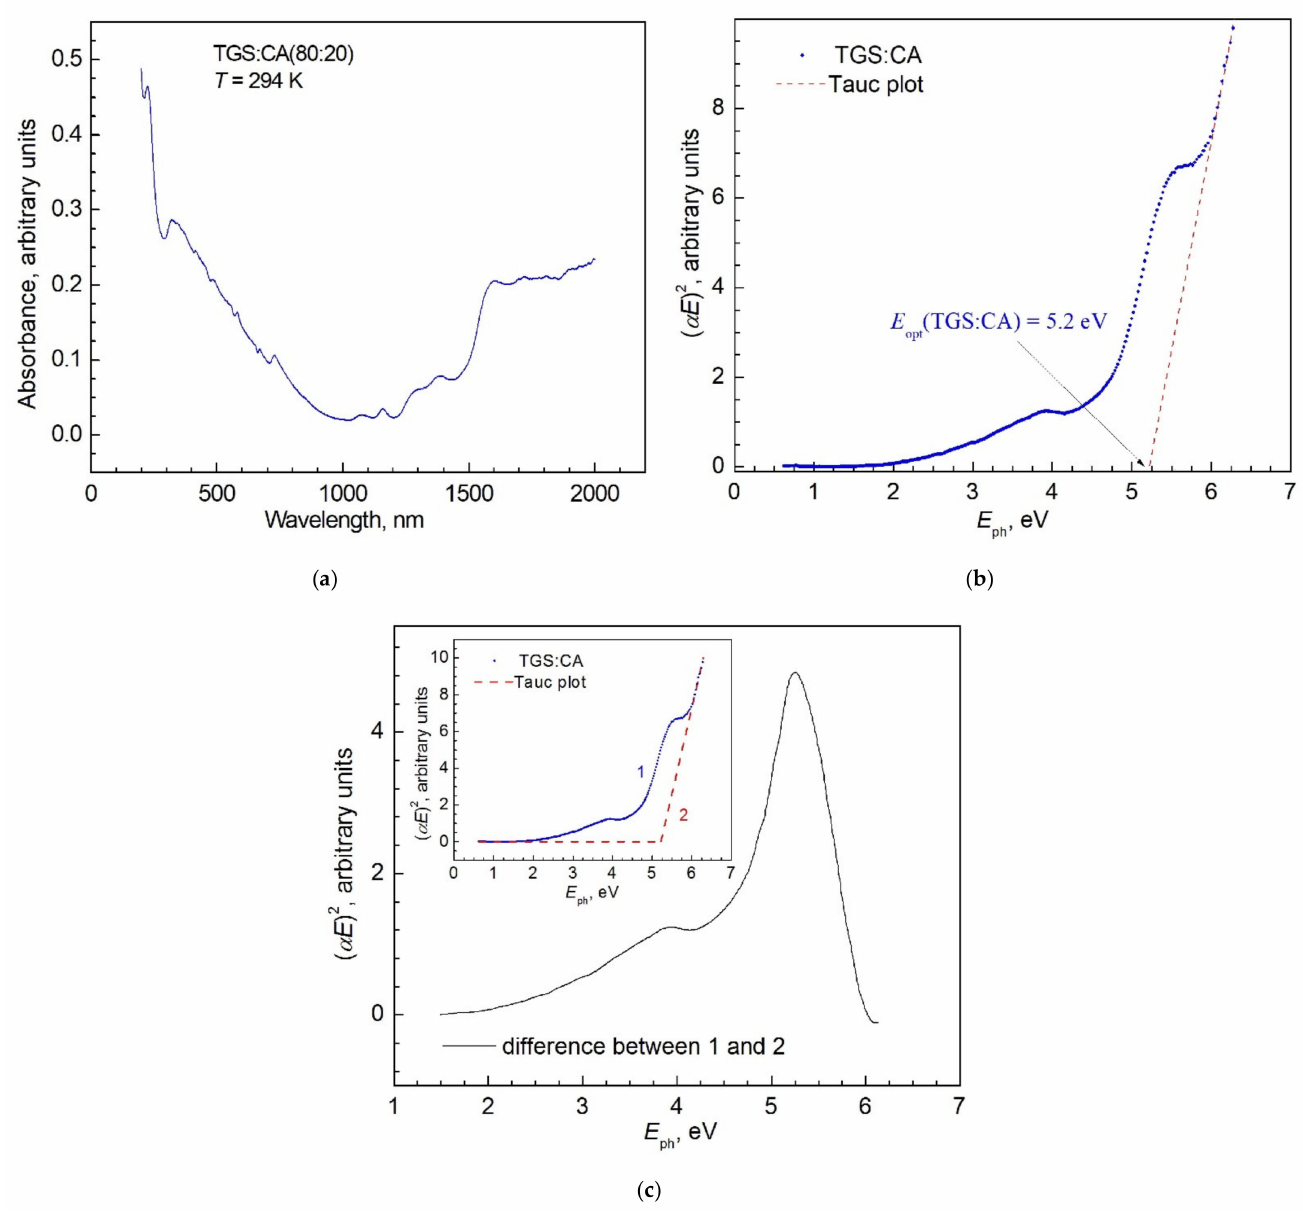
Figure 7. ( a ) UV-Vis absorption spectrum of TGS:CA (80:20) crystal. ( b ) Fragment of the TGS:CA UV-Vis absorption spectrum (blue dots) in Tauc coordinates and direct allowed band gap Tauc plot (dashed red) related to the fundamental absorption edge of TGS:CA (80:20). ( c ) Structure of the TGS absorption is caused by the incorporation of CA molecules into the TGS crystal. Inset in ( c ) is presented for the explanation of